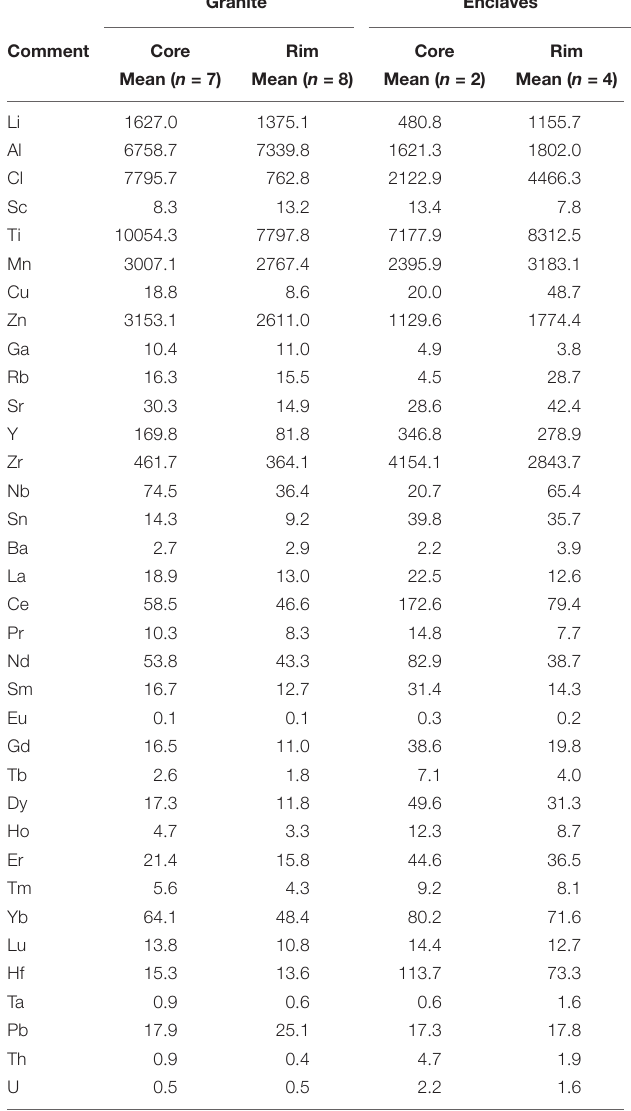
TABLE 2 | Average trace element concentrations (in ppm) of the amphiboles from the host granite and MMEs. Granite Enclaves